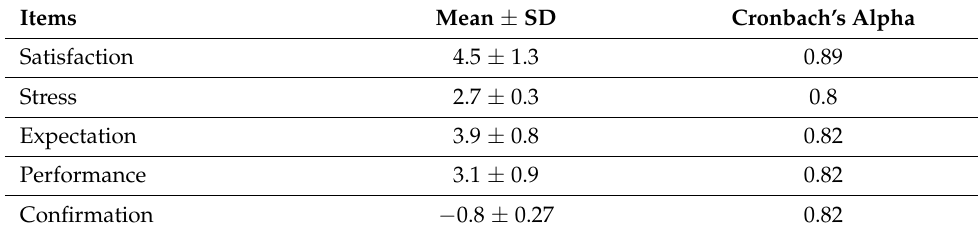
Table 2. Descriptive statistics and reliability of the used